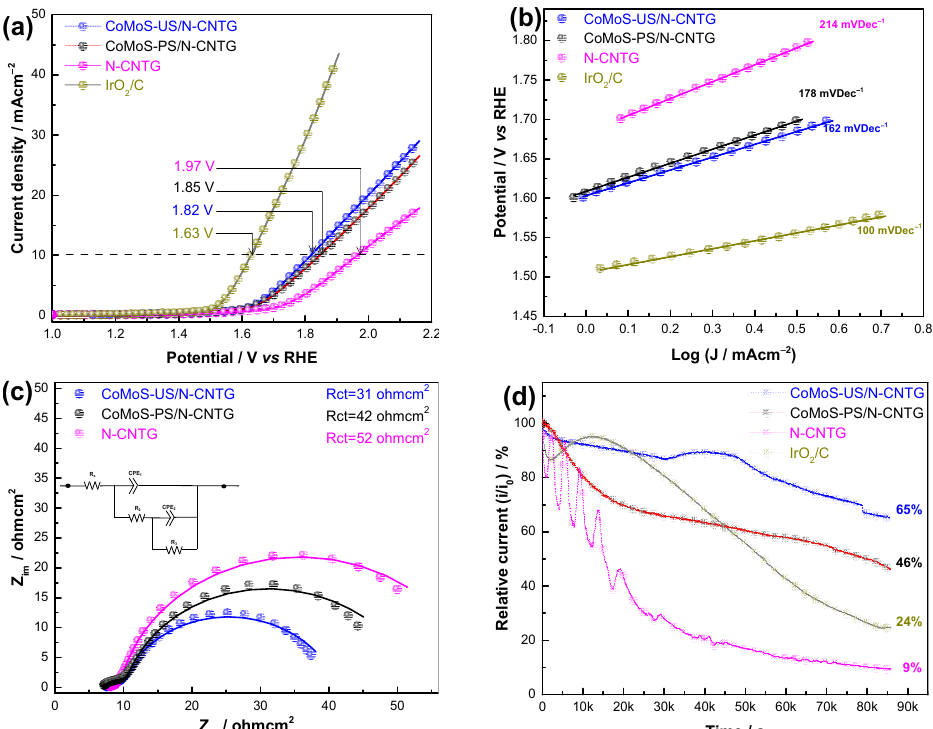
Figure 6. ( a ) Electrocatalytic OER activity of the non-noble’s catalyst and its IrO 2 /C counterparts; ( b ) Tafel plots obtained using the LSV curves for the tested materials; ( c ) EIS spectra for the synthesized materials; and ( d ) OER stability curves in N 2 -saturated 0.1 M KOH solution for all materials.